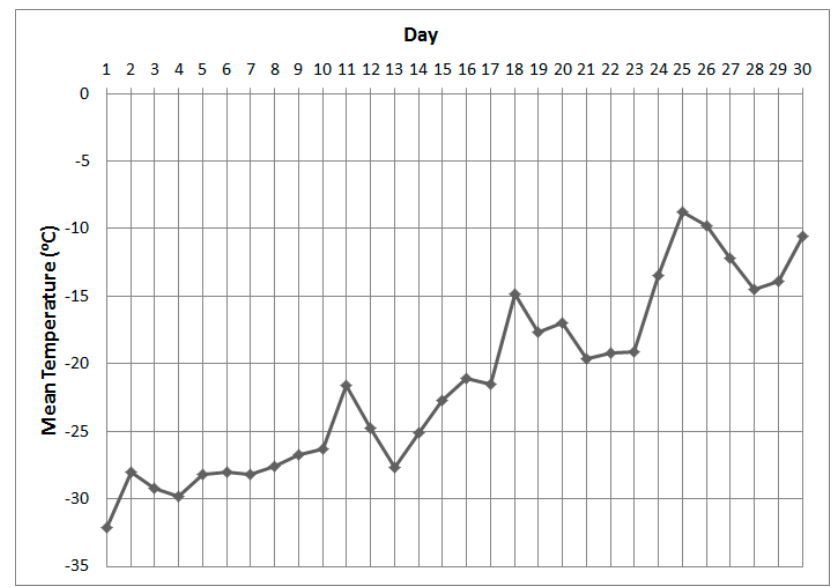
Figure 2. Daily mean temperature for April 2015 recorded at the Gjoa Haven weather station. Table 1. Summary of Synthetic Aperture Radar (SAR) image